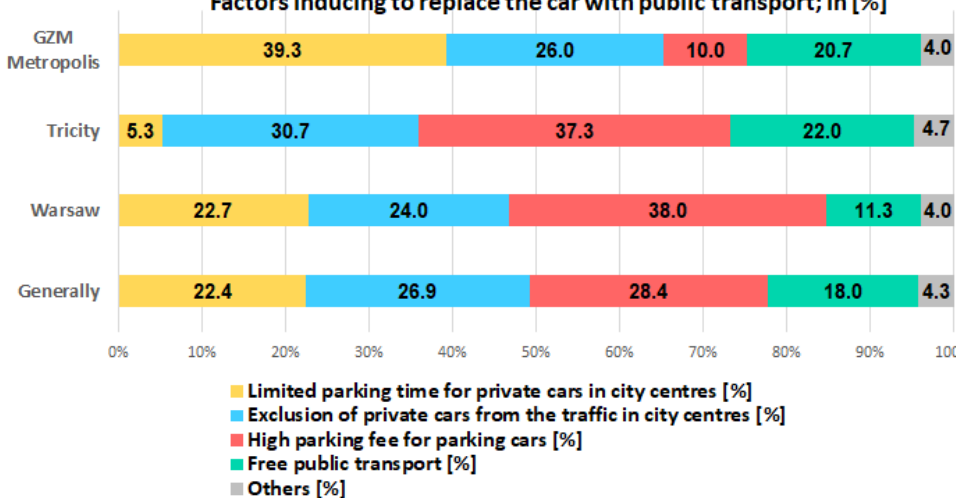
Figure 2. Factors inducing to replace the car with public transport. Source: based on [3].